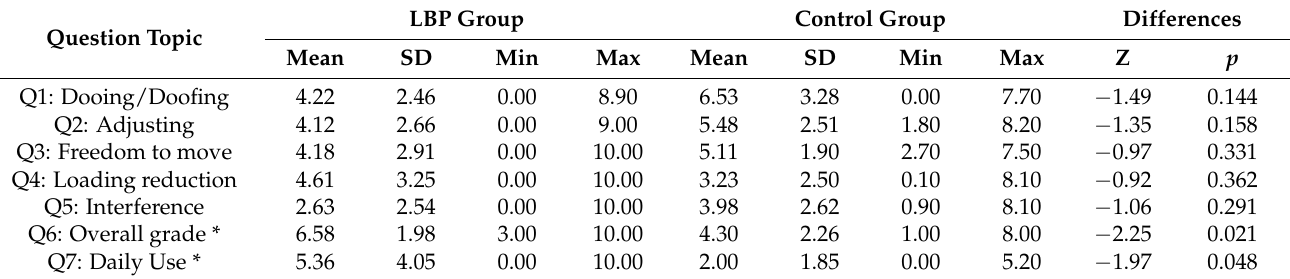
Table 2. Summary of user impression